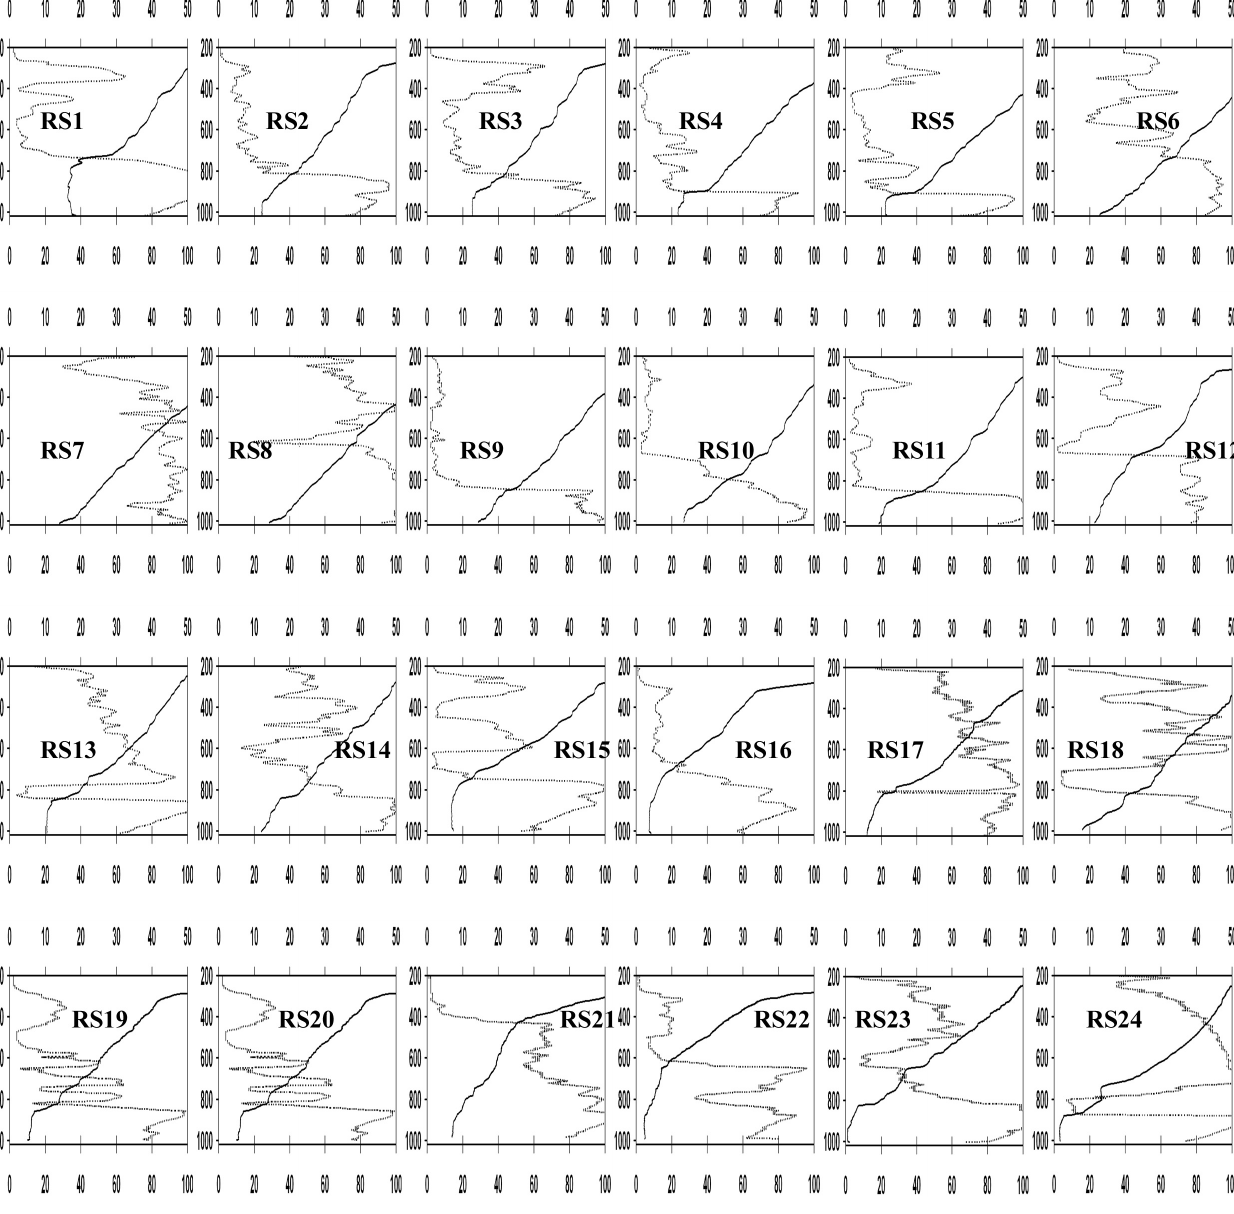
wind profiles, respectively, derived from all the radiosonde